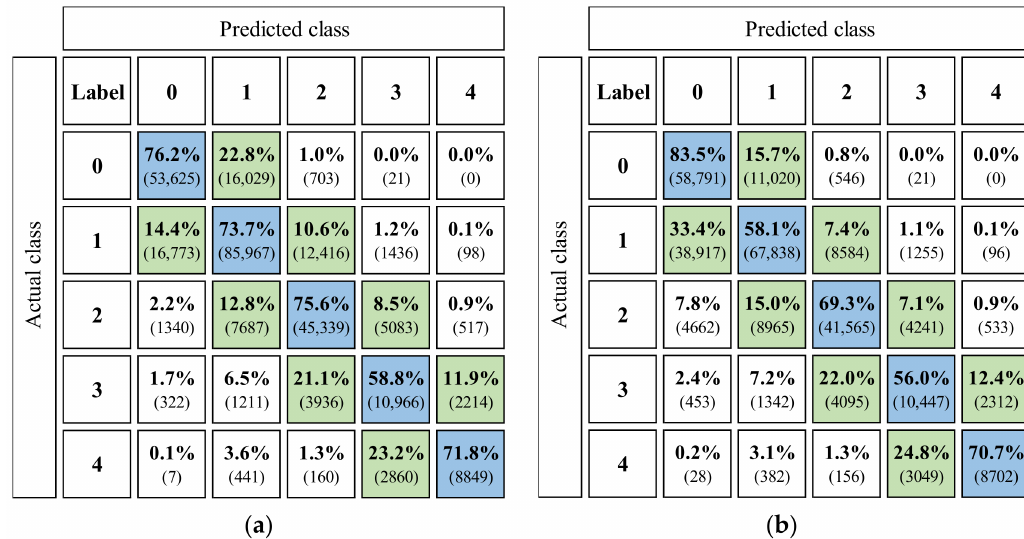
Figure 14. Confusion matrices of the method based on ground motion intensity measures: ( a ) LightGBM (prediction accuracy = 73.7%); ( b ) XGBoost (prediction accuracy = 67.4%).